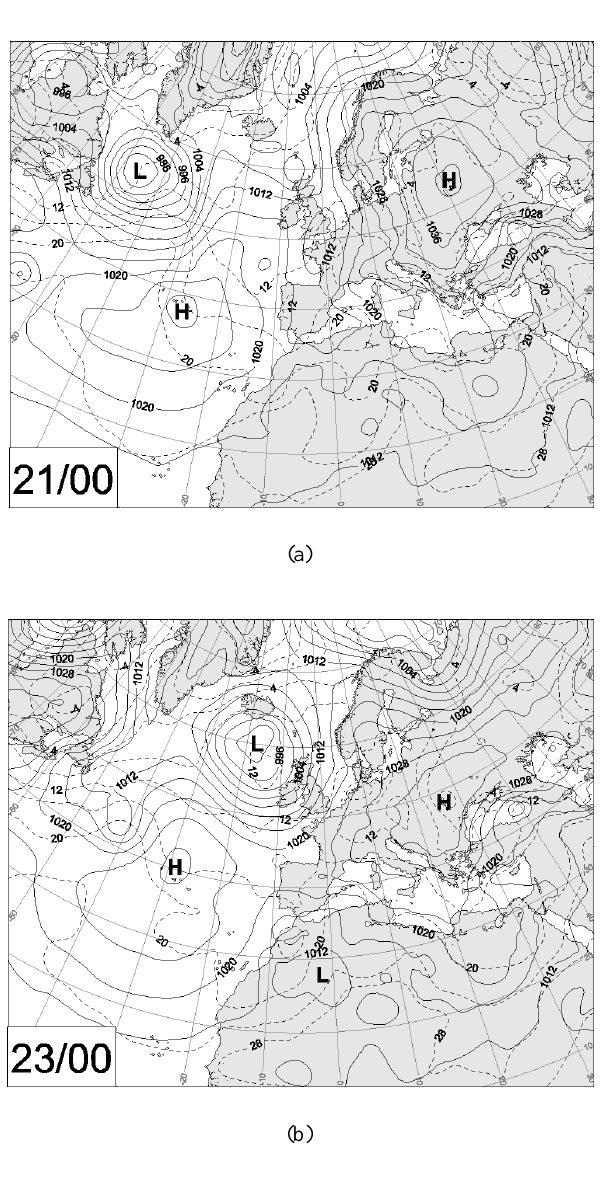
Fig. 4. Temperature at 925hPa ( ◦ C, dashed line) and sea level pressure (hPa, solid line) obtained from the NCEP analysis on 00:00UTC (a) 21 and (b) 23 October